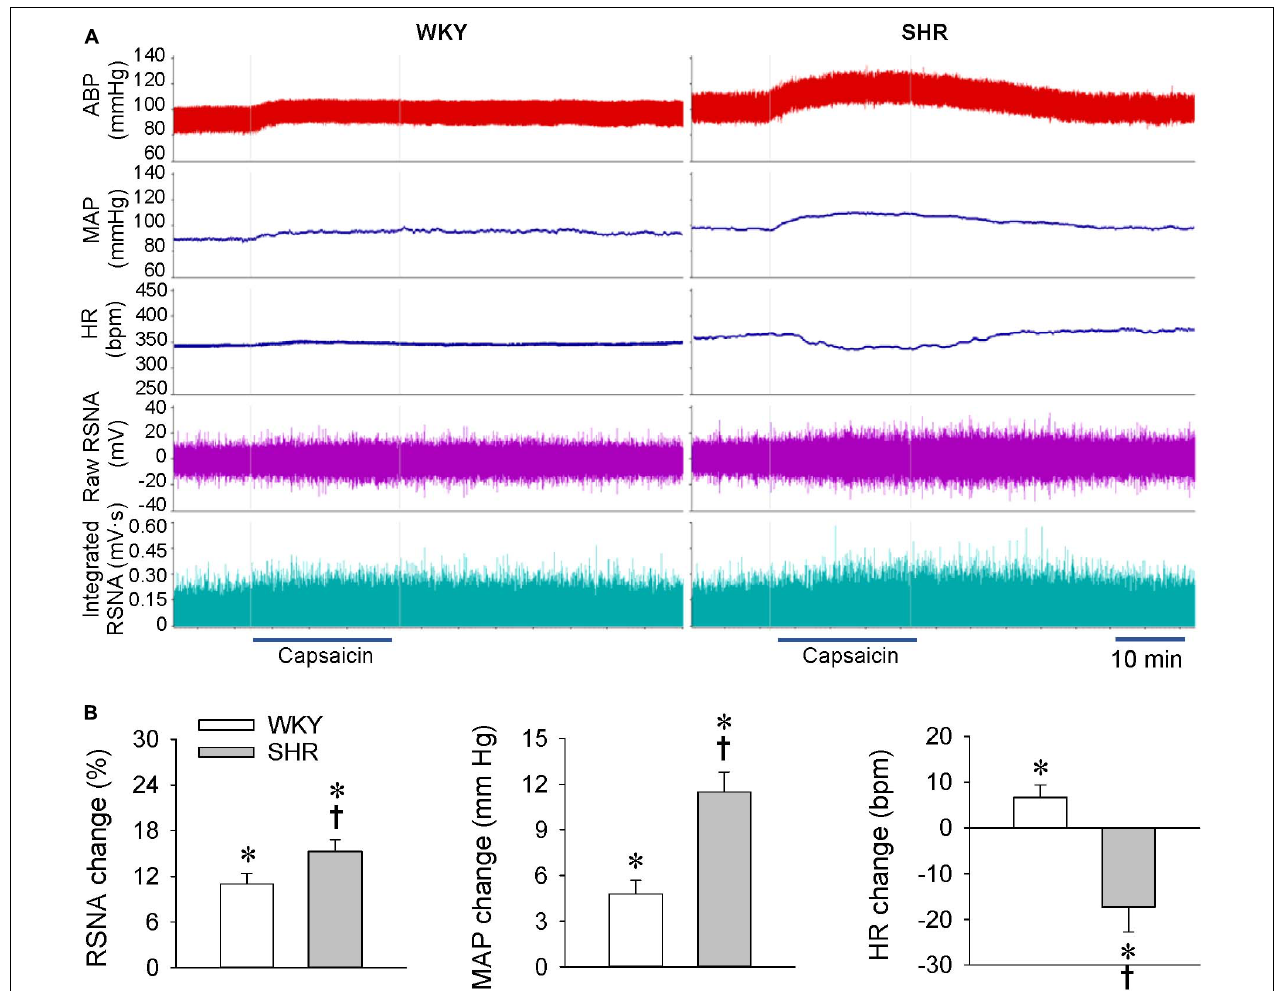
FIGURE 1 | ERR in the WKY and SHR at the age of 4 weeks. The ERR was induced by renal infusion of capsaicin at 1 nmol/min for 20 min. (A) representative recordings showing the recordings of the capsaicin-induced ERR. (B) bar graph showing the capsaicin-induced ERR. Values are mean ± SE. ∗ P < 0.05 vs the values before renal infusion; † P < 0.05 vs WKY. n =